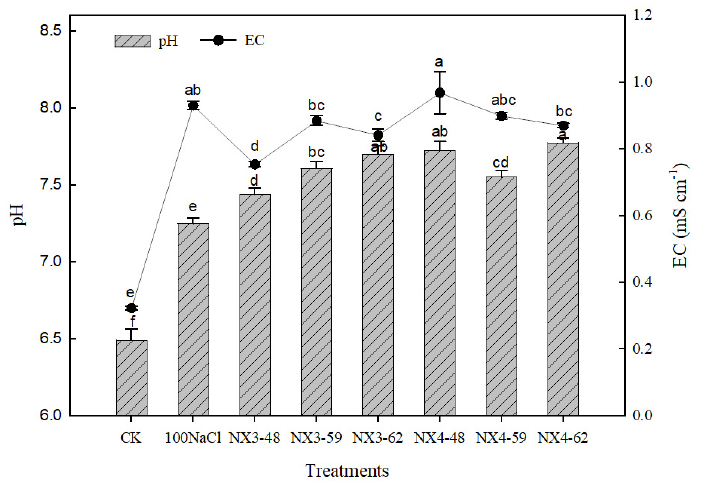
Figure 4. Substrate pH and EC in a pot experiment in which cucumber seedlings inoculated with a combination of Bacillus licheniformis and Bacillus subtilis under salt stress were grown for 40 days. Bars represent standard errors. Different letters indicate a significant difference in the same parameter at p < 0.05.